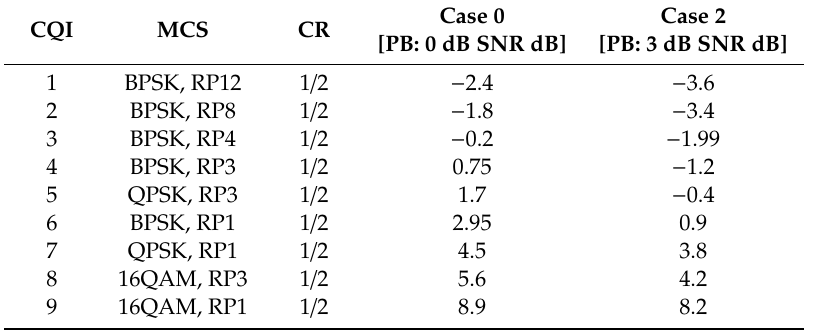
Figure 9. BLER curves for PA scenario P B 2. Table 4. SNR comparison of MCS levels at 10 − 1 BLER under the south sea fading